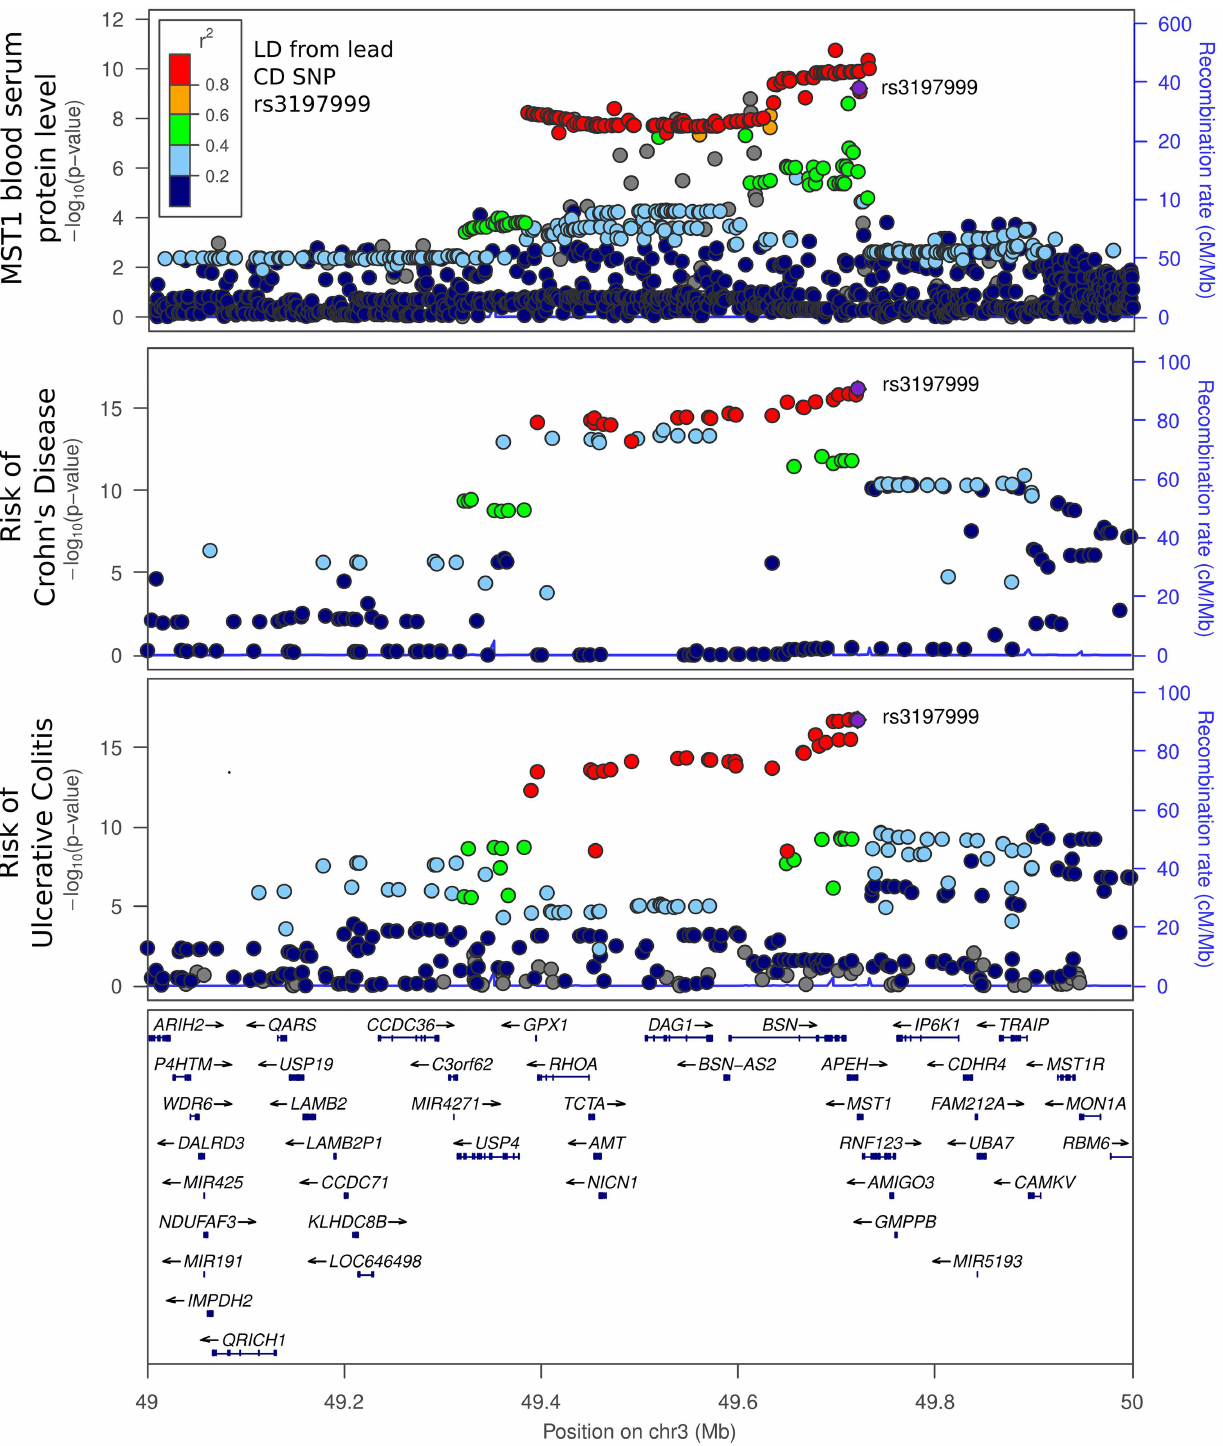
Fig 5. Locuszoom plot of MST1, CD and UC association pvalues around the MST1 gene. It is worth notingthat our proteomics platform has 4 probes in this chromosomalregion, targeting 4 different proteins: IMPDH2 (probe SL010928), MST1 (probe SL005202), MST1R (probe SL004637) and MAPKAPK3 (probe SL004765). Of these, MST1 is most significantly associated with the IBD GWAS SNP in this locus (S3 Fig), and the associationpattern was highlyconsistent with the CD and UC GWAS peaks (Fig